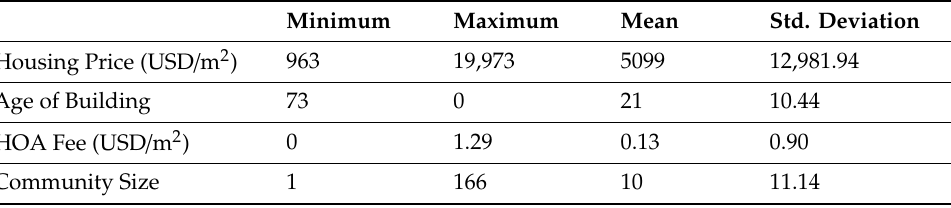
Table 1. Descriptive